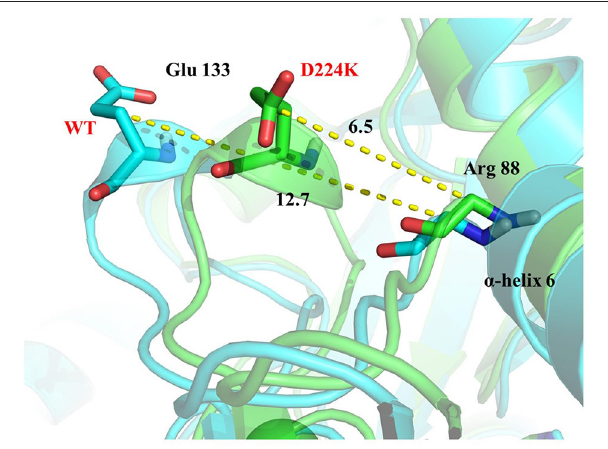
FIGURE 5 | 3D view of the surrounding structure of α -helix 8 surrounding on the wild type (blue) and D224K